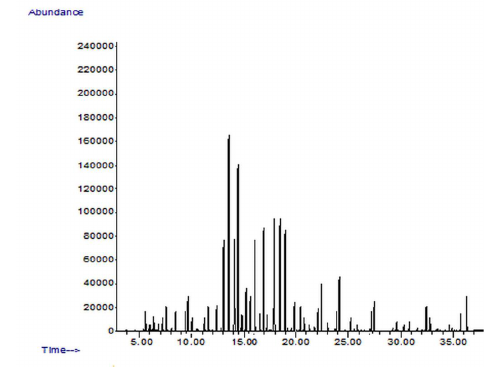
Fig 4: GC chromatogram for volatile